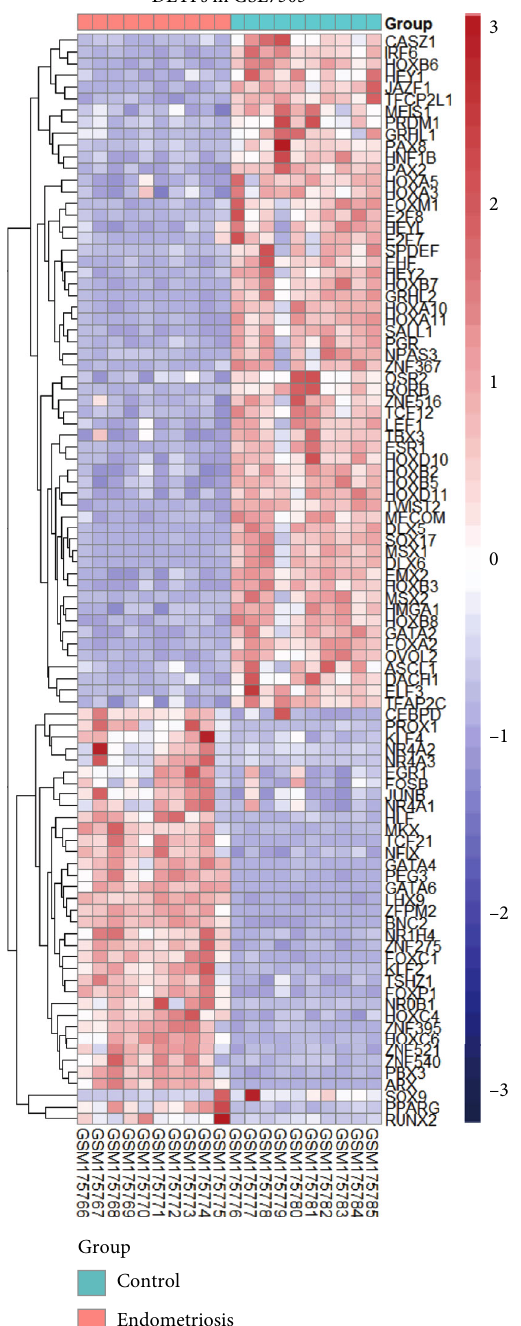
Figure 4: Heatmap of 94 DETFs in GSE7307. Each row represents a TF and each column represents a